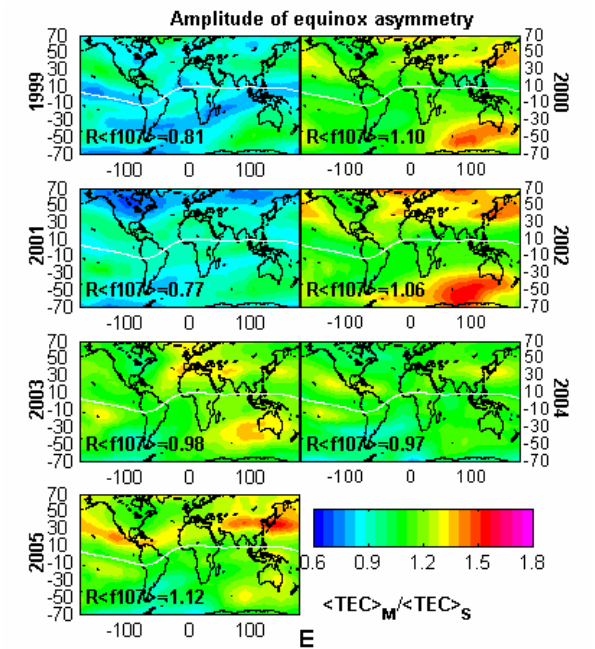
Figure 6. Global distributions of amplitudes of the annual and semiannual component (A, B) and phase of the annual variation (C), and position of maximum value exist (D) and Amplitude of equinox asymmetry. White line denotes the magnetic equator (E). x and y axes are the geographic longitude and latitude and the white line is the dip equator.